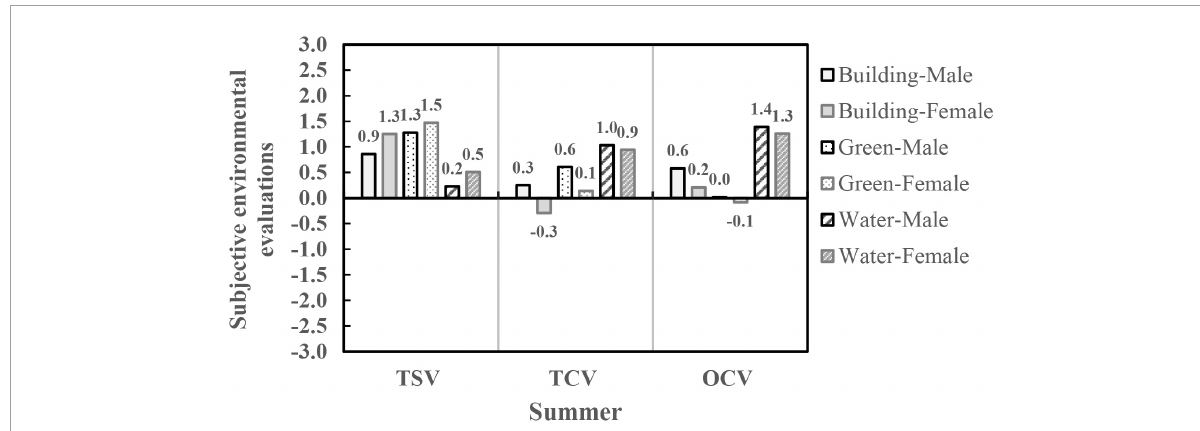
FIGURE6 Subjective environmental evaluations of different genders in visual landscape scenes.